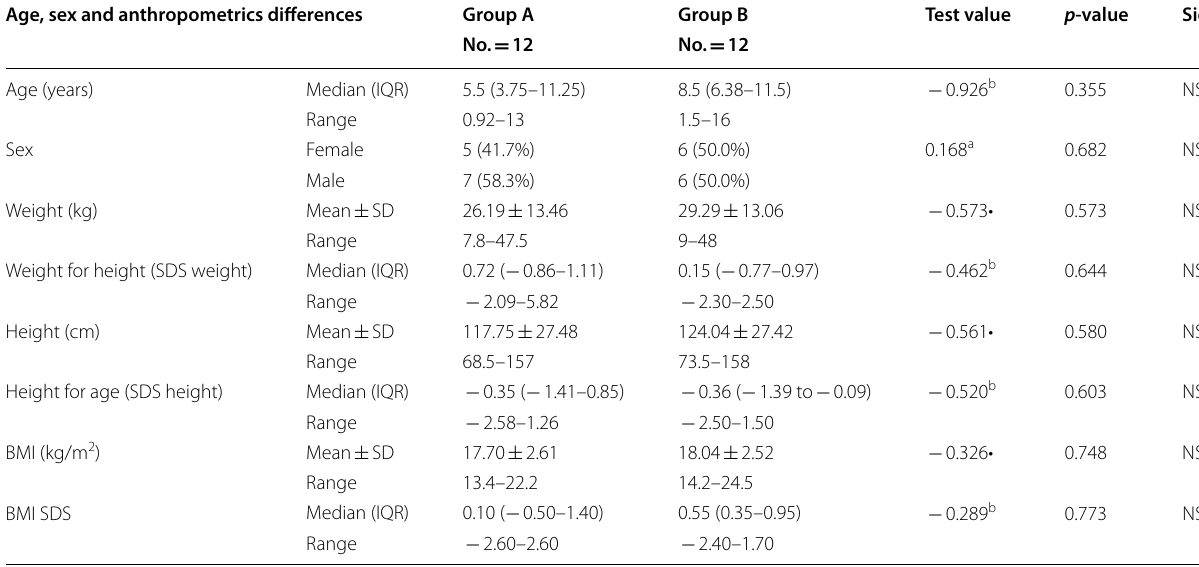
Table 3 Comparison between group A and B regarding age, sex and anthropometrics